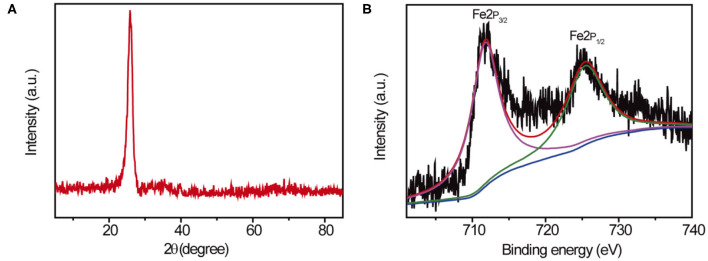
(A) XRD spectra of Fe2O3/CNTs and (B) the XPS core level of Fe2p.